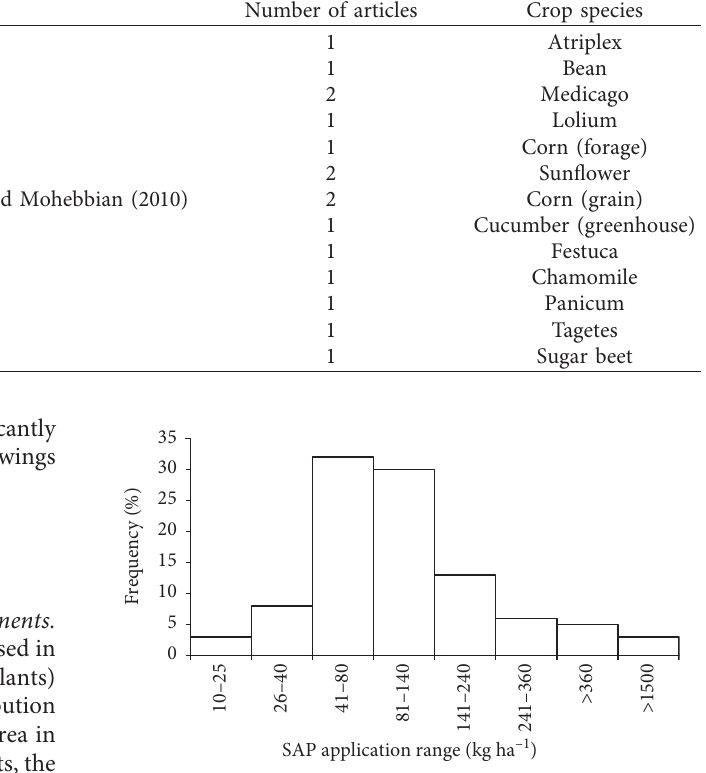
Figure 1: Frequency distribution of superabsorbent application levels in the studied